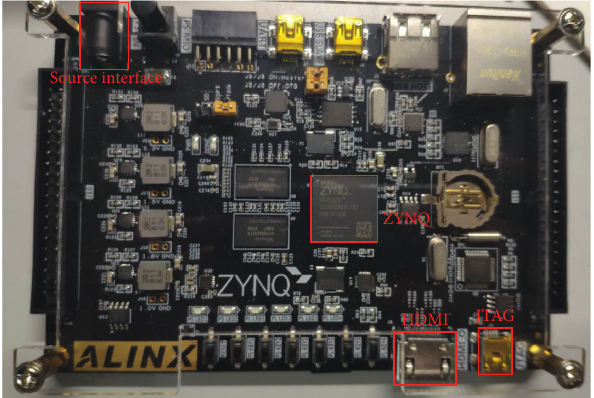
Figure 2: FPGA hardware diagram.